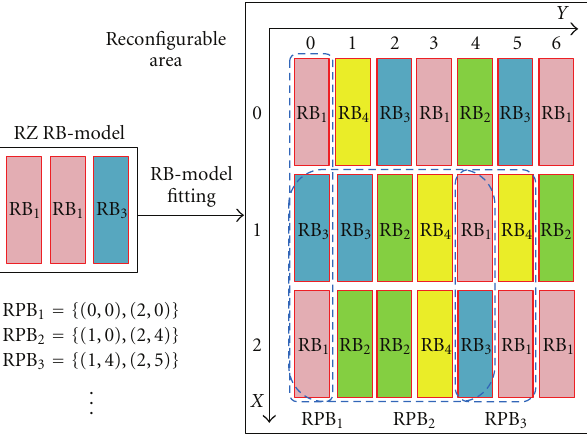
Figure 7: Example of RPBs for